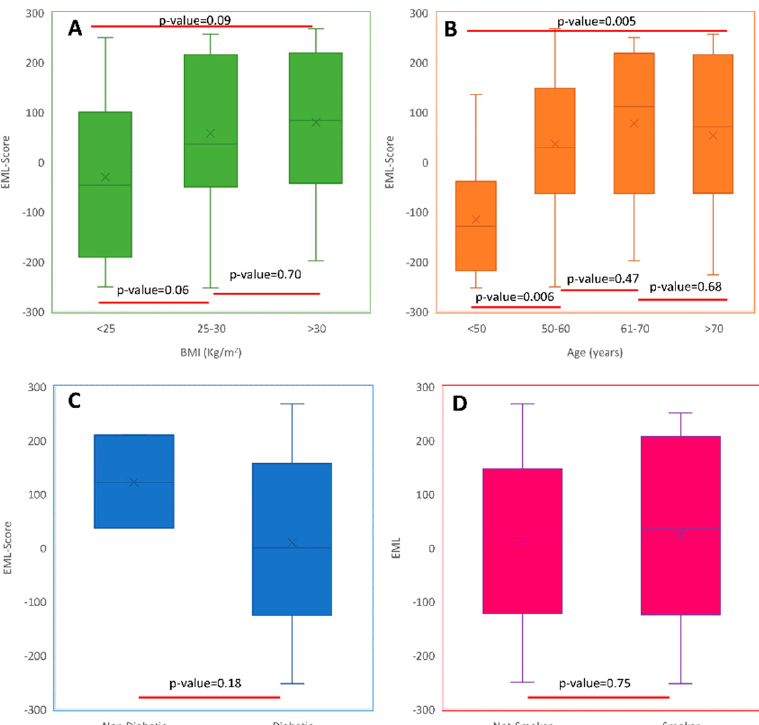
Figure 4. Box and whiskers plot reporting the EML score distribution in ( A ) normal weight (BMI < 25 kg/m 2 ), overweight (25 < BMI < 30) and obese (BMI > 30 kg/m 2 ) subjects; ( B ) subjects with <50 years, 51–60, 61–70 and >70 years; ( C ) in diabetic and non-diabetic subjects; ( D ) in smoker and not-smoker